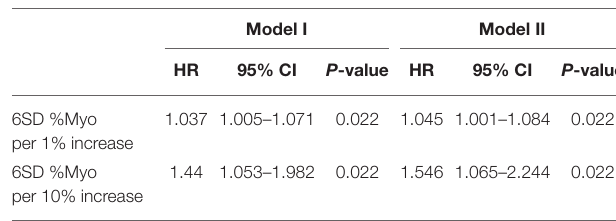
TABLE 3 | Multivariate analysis with LGE-CMR quantification for major adverse events in patients with Stage C or D heart failure during follow-up.